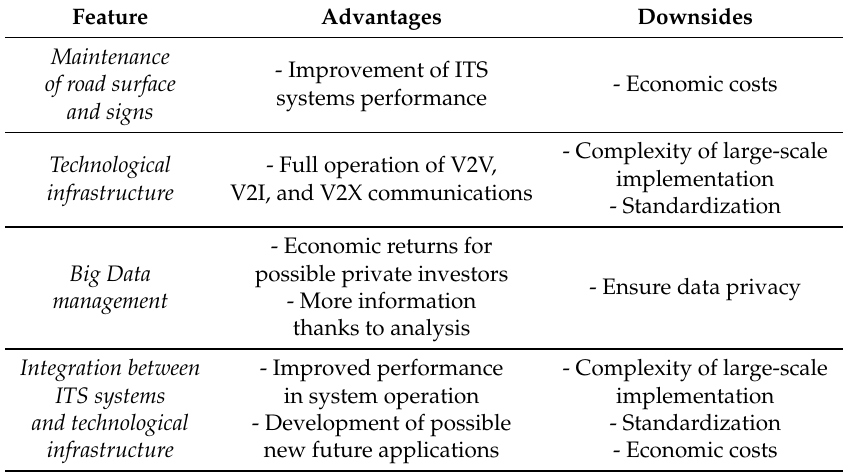
Table 2. Some purposes and downsides of future 5G-enabled vehicular communications.